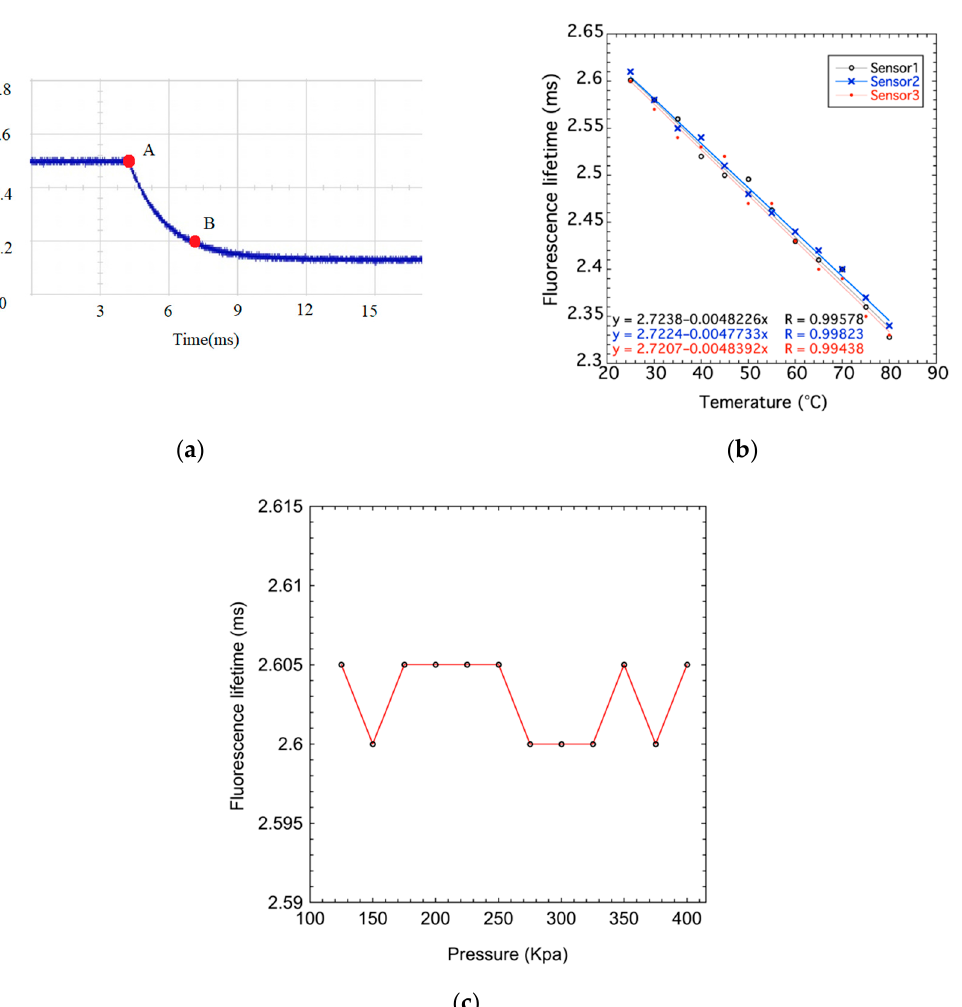
Figure 10. Characteristic of fluorescence lifetime in the hybrid fiber-optic F–P sensor. ( a ) Fluorescence decay curves at room temperatures, ( b ) Relationship between fluorescence lifetime and temperature, and ( c ) relationship between fluorescence lifetime and pressure.